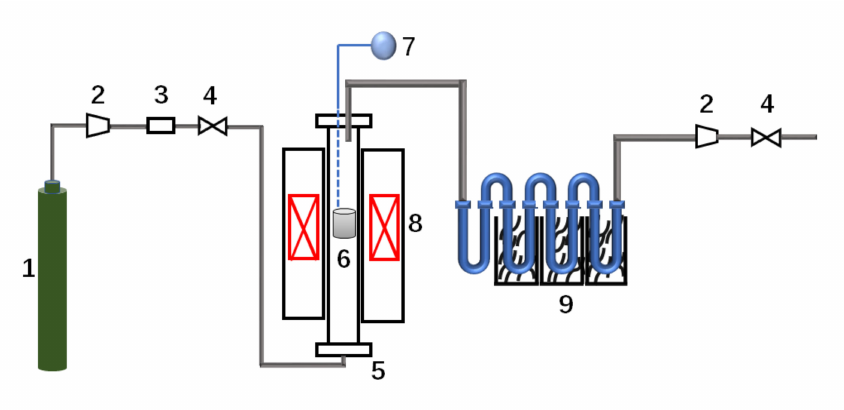
Figure 1. Schematic diagram of experimental device. 1. Gas cylinder; 2. Pressure-regulating device; 3. Gas drying device; 4. Mass flowmeter; 5. Pyrolysis reactor; 6. Biomass; 7. Explosion-proof alarm device; 8. Heating device; 9. Condenser